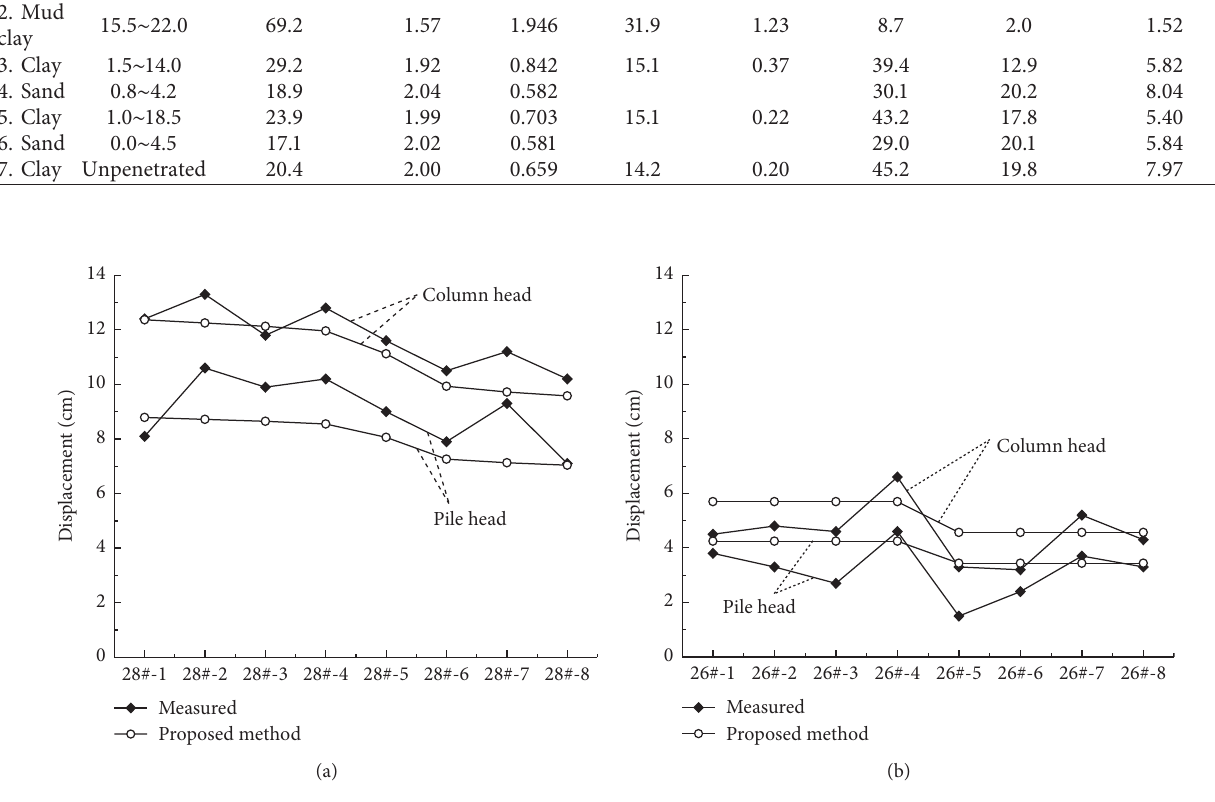
Figure 9: Measured and computed displacement. (a) #28 piers. (b) #26 piers.